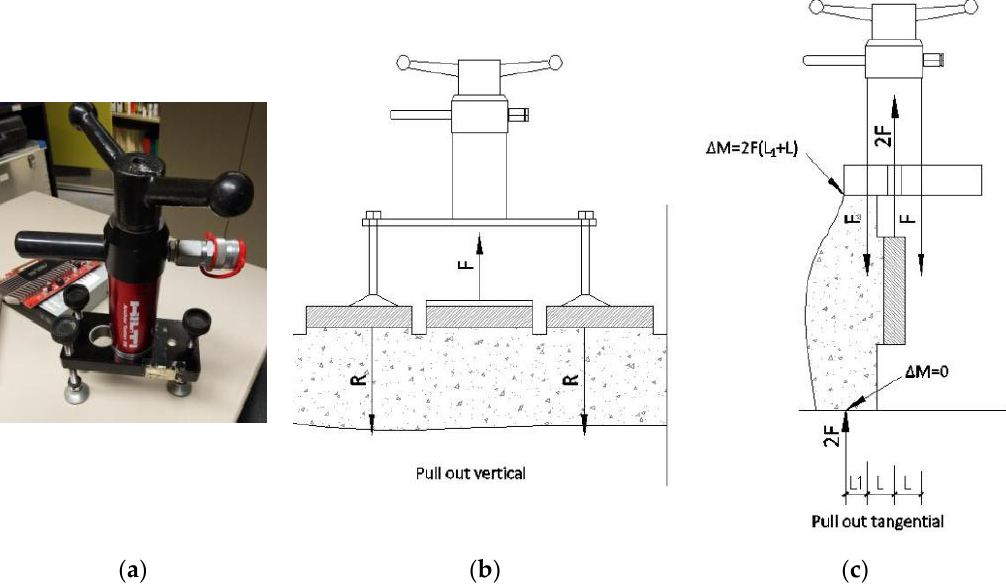
Figure 4. Location of the specimens to carry out the pull-out tests on each masonry piece. ( a ) Manual jack, ( b ) tensile and ( c ) direct shear types.